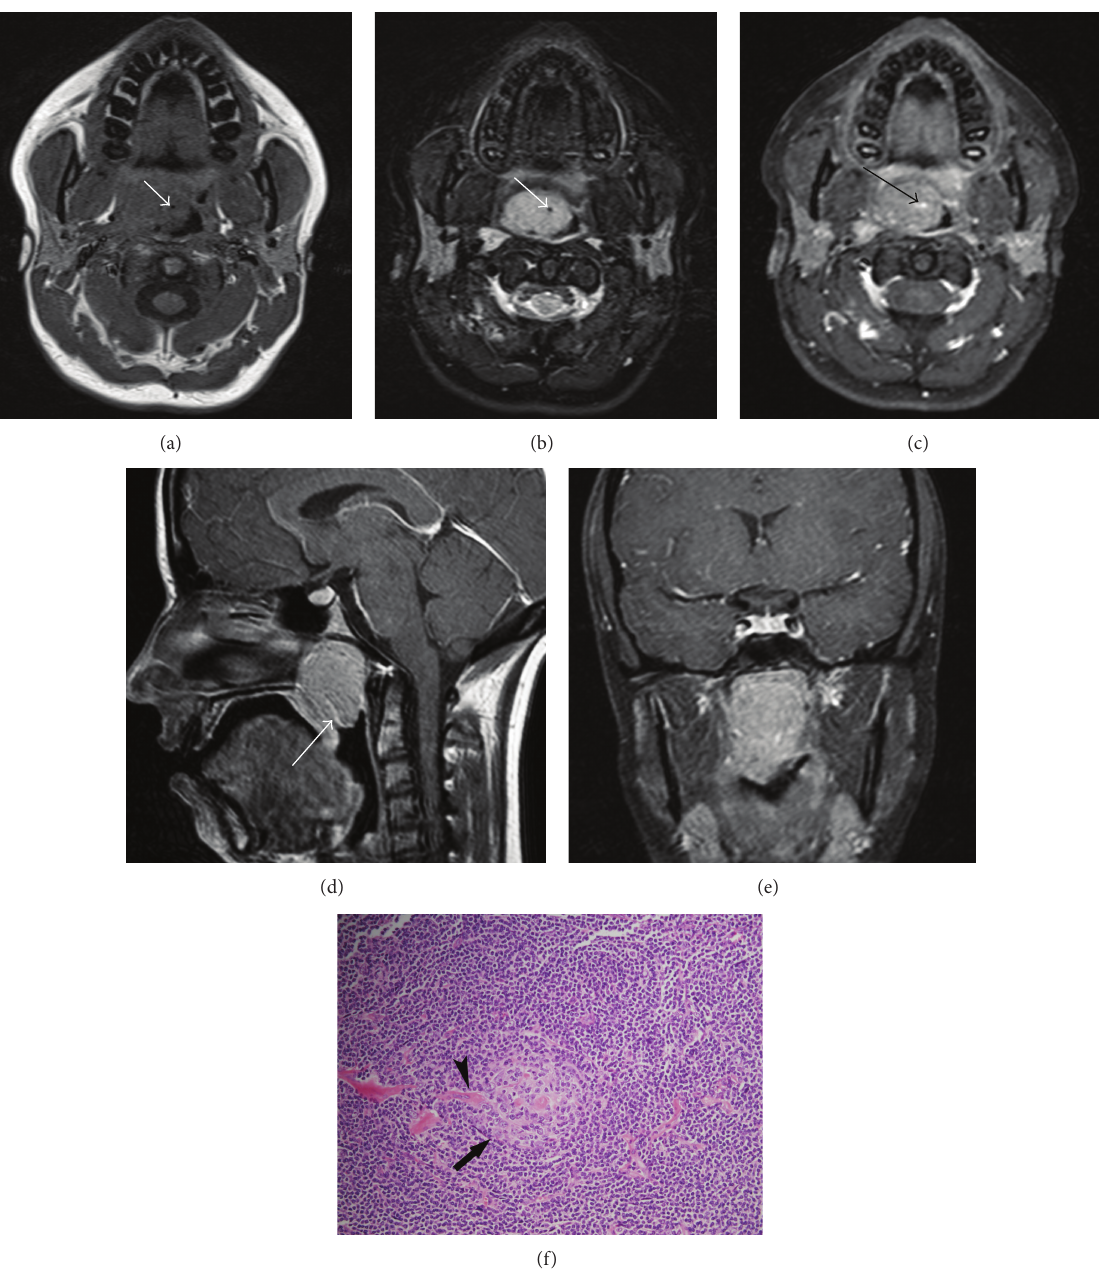
Figure 1: MRI scan demonstrates a homogeneous mucosally based mass occupying almost the entire nasopharyngeal airway extending from the posterior margin of the nasal septum anteriorly to the fossae of Rosenmuller posteriorly. The mass is isointense on unenhanced T1- weighted image (a) and hyperintense on T2-weighted image (b) and shows moderate contrast enhancement (c, d, and e). A hypointense curvilinear flow void that enhances avidly representing the feeding vessel is in the inferior aspect of the tumour (white arrows). (f) Photomicrograph (original magnification × 200) haematoxylin-eosin stain shows lymphoid follicle (black arrow) with atrophic germinal centre. The follicle is rimmed by a concentric layer of small lymphocytes. The germinal centre is penetrated by hyalinised vessels (black arrow head) and there is an increase in interfollicular vasculature. Reactive small lymphocytes are present in the interfollicular regions. The features are consistent with hyaline vascular Castleman’s